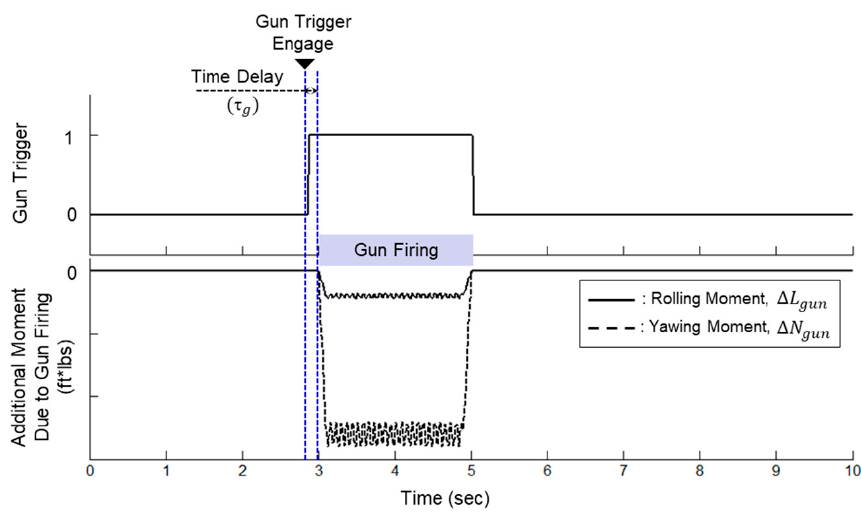
Figure 5. Modeling of additional moment due to reaction force during gun fi ring.